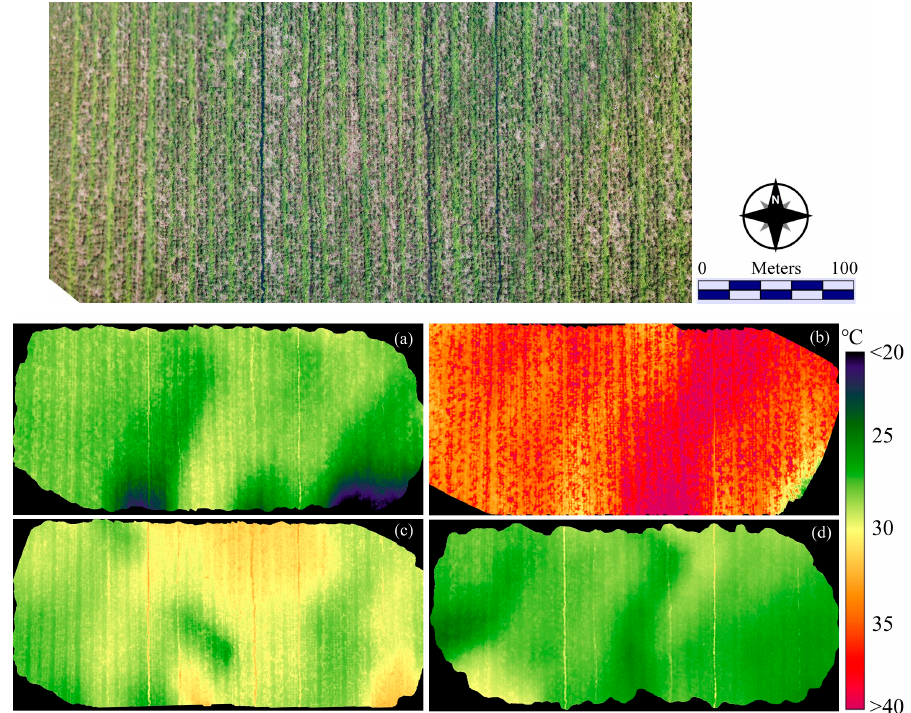
Figure 2. RGB orthoimage of the study area ( top ) and the processed thermal images at different times and on different days ( bottom ): ( a ) 30 January 7:00 ( b ) 30 January 14:00 ( c ) 30 January 19:00 ( d ) 31 January 7:00.